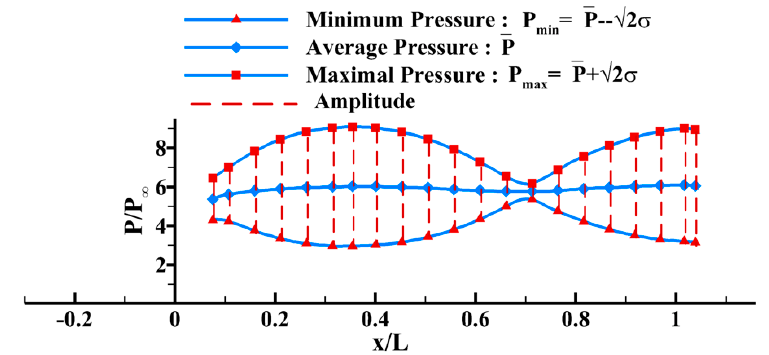
Figure 8. Standard deviation distribution inside the inlet.